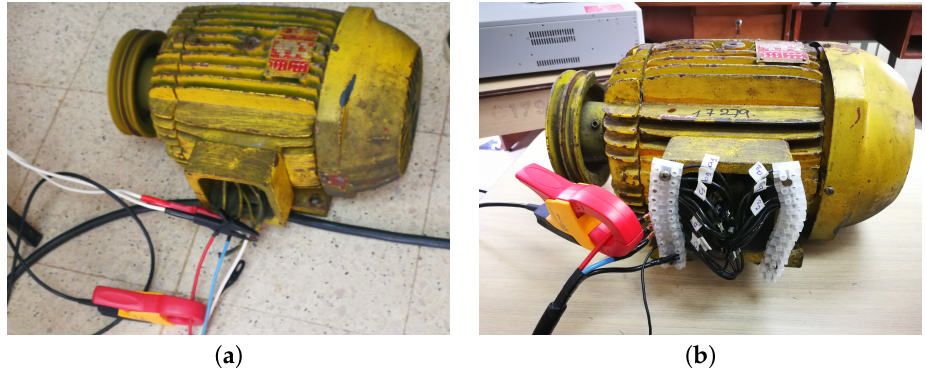
Figure 10. Experimental setup for non-load test. ( a ) Three-phase IM. ( b ) Nine-phase IM.